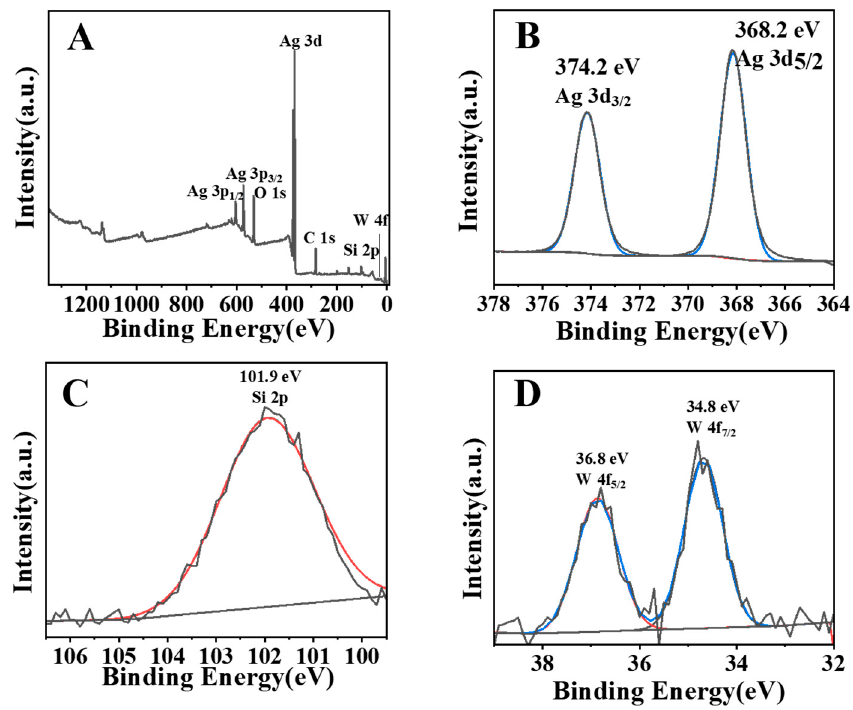
Figure 4. XPS spectra of AgSW-4 ( A ), Ag 3 d ( B ), Si 2p ( C ), and W 4f ( D ). The red and blue lines are curves fitted by XPS data analysis software.